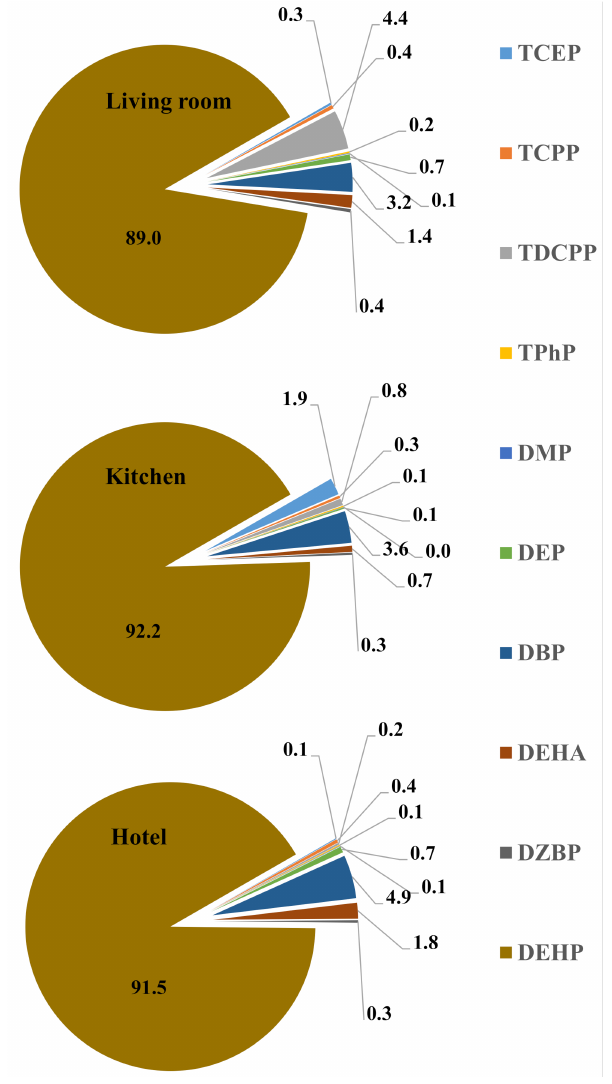
Figure 2. Contribution (%) of analyzed chemicals in indoor dust of sampled indoor microenviron- ments of Saudi